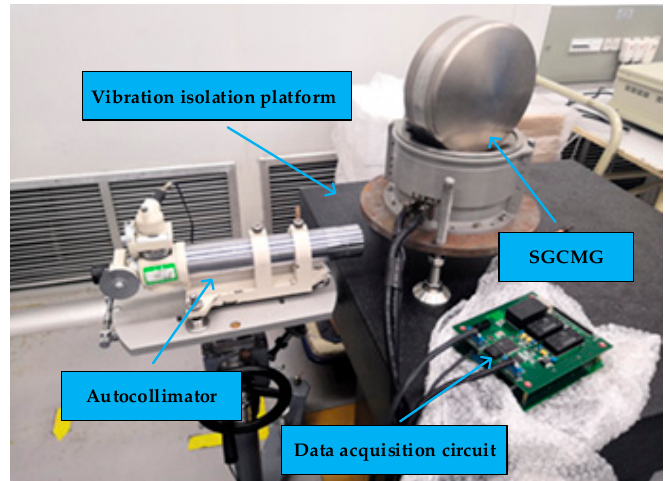
Figure 5. Calibration experiment.